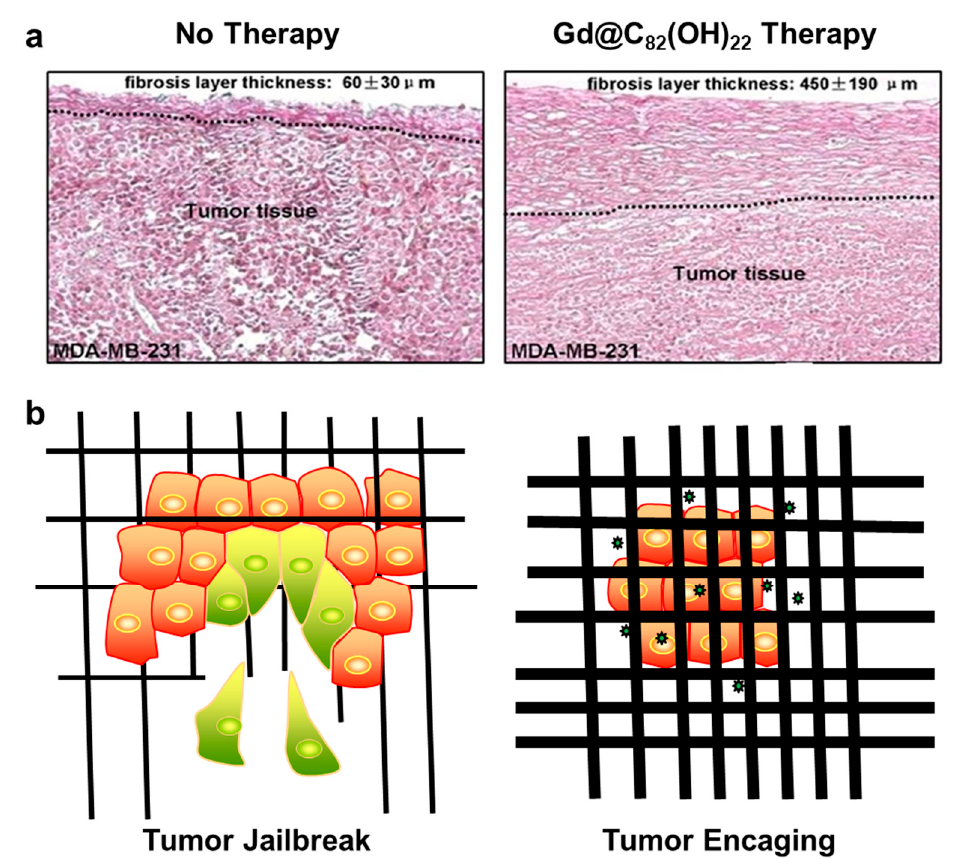
Figure 2. Schematic presentation of tumor encaging by Gd@C 82 (OH) 22 . Instead of directly poisoning tumor cells, Gd@C 82 (OH) 22 encaged tumor via MMP inhibition and collagen stabilization. In the control mice (left panel), MMP secreted by tumor-associated macrophages (TAMs) efficiently degraded the collagen-consisting fibrous matrices. Consequently, tumor cells escaped and tumor metastasis occurred. In Gd@C 82 (OH) 22 -treated mice (right panel), Gd@C 82 (OH) 22 decreased MMP production and activity and furthermore stabilized collagen by facilitating the formation of collagen microfibrils. The formed thick fibrous layers imprisoned tumor cells and the tumor failed to metastasize. ( represents Gd@C 82 (OH) 22 molecule). Adapted with permissions from Meng, H, Nanomedicine; published by Elsevier Inc.